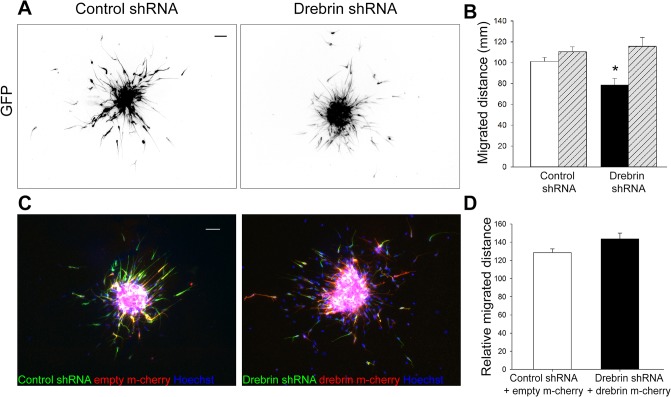
Drebrin regulates RMS neuroblast migration in vitro.(A) Reaggregated rat neuroblasts were embedded in Matrigel 52 h after nucleofection of control or drebrin shRNA-GFP and allowed to migrate for 24 h. Representative images of fixed reaggregates immunostained for GFP. The GFP channel is shown as a grayscale image. (B) Drebrin-depleted neuroblasts (black column) show a ~20% decrease in migration distance compared to control shRNA-nucleofected cells (white column). GFP-negative, untransfected cells (hatched columns) served as an internal control (mean ± SEM; n = 3 independent experiments; 15 to 20 explants analysed per experiment; *P<0.05). (C) Reaggregated rat neuroblasts were embedded in Matrigel 52 h after nucleofection with control shRNA-GFP and m-cherry-empty vector or drebrin shRNA-GFP and m-cherry-human drebrin (shRNA-resistant) and allowed to migrate for 24 h before immunostaining for GFP (green) and m-cherry (red). Cell nuclei were visualized by Hoechst staining (blue). (D) The impaired migration caused by drebrin knockdown was rescued by co-transfection with the shRNA-resistant human drebrin (mean ± SEM; n = 3 independent experiments; 15 to 20 explants analysed per experiment). Scale bars: 50 μm.